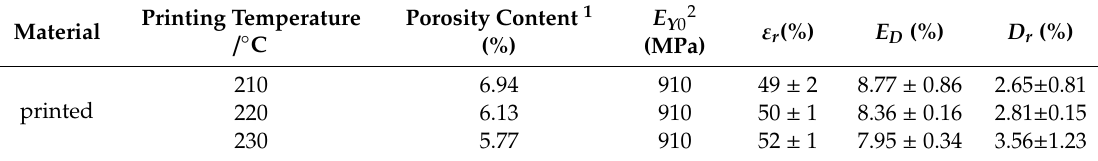
Table 2. Predicted mechanical parameters of 3D-printed PLA as a function of printing temperature. 1 based on X-ray micro-tomography, 2 Material